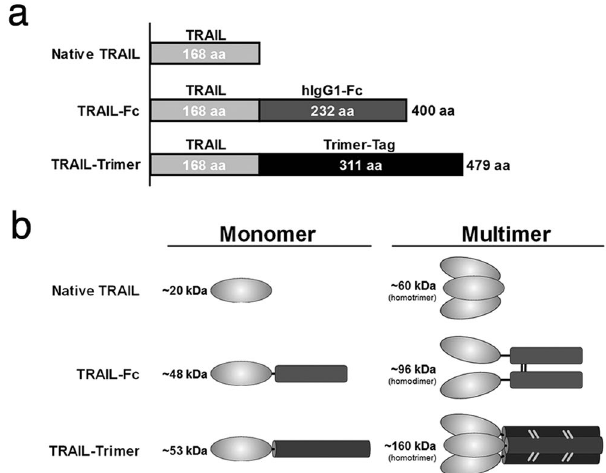
Figure 1. Structures of different TRAIL polypeptides. ( a ) Three recombinant soluble forms of human TRAIL have been used in this study: a native TRAIL comprised of the extracellular domain of TRAIL, a dimeric TRAIL-Fc comprised of extracellular TRAIL domain fused to human IgG1 Fc domain, and a TRAIL-Trimer comprised of extracellular TRAIL domain fused to Trimer-Tag. Amino acid sequence lengths are shown for each protein and domain respectively. ( b ) Theoretical molecular weights (kDa) of both monomeric and multimeric forms of native TRAIL, TRAIL-Fc and TRAIL-Trimer, respectively. Native TRAIL associates into